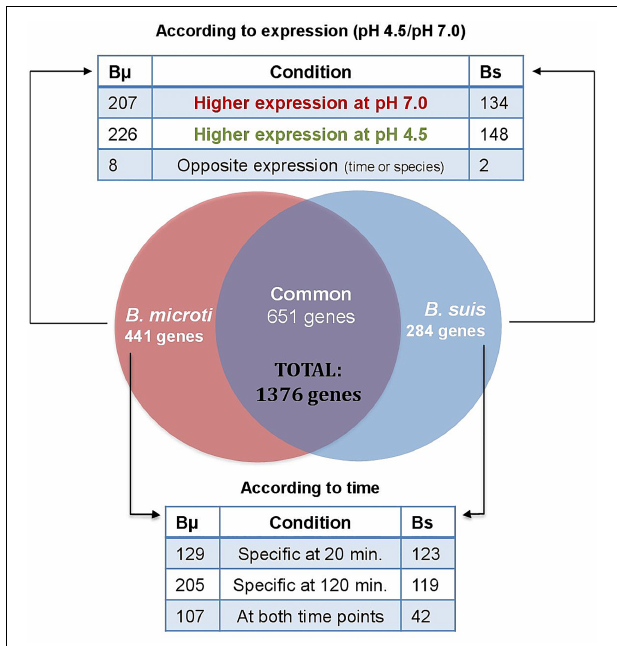
FIGURE 2 | Distribution of differentially expressed genes in B. microti and B. suis . Numbers of genes differentially expressed in both species at pH 4.5/pH 7 were determined either according to the rates of expression at both pH-values (upper panel), or according to the time points where differential expression was significant (lower panel). B µ : B. microti ; Bs: B. suis